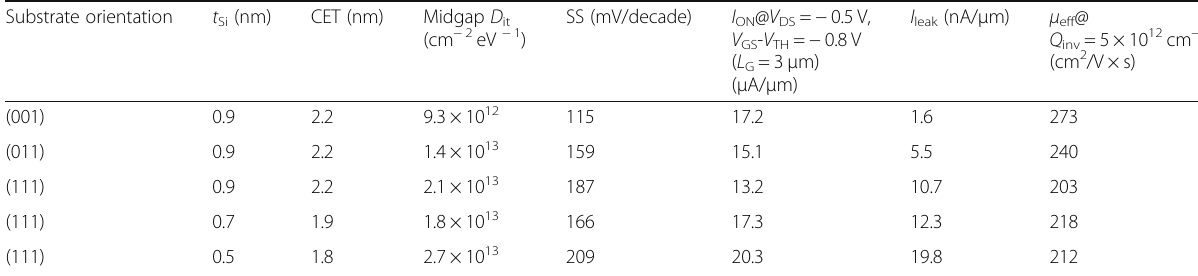
Table 1 Key electrical performance of Ge pMOSFETs on the different orientations Substrate